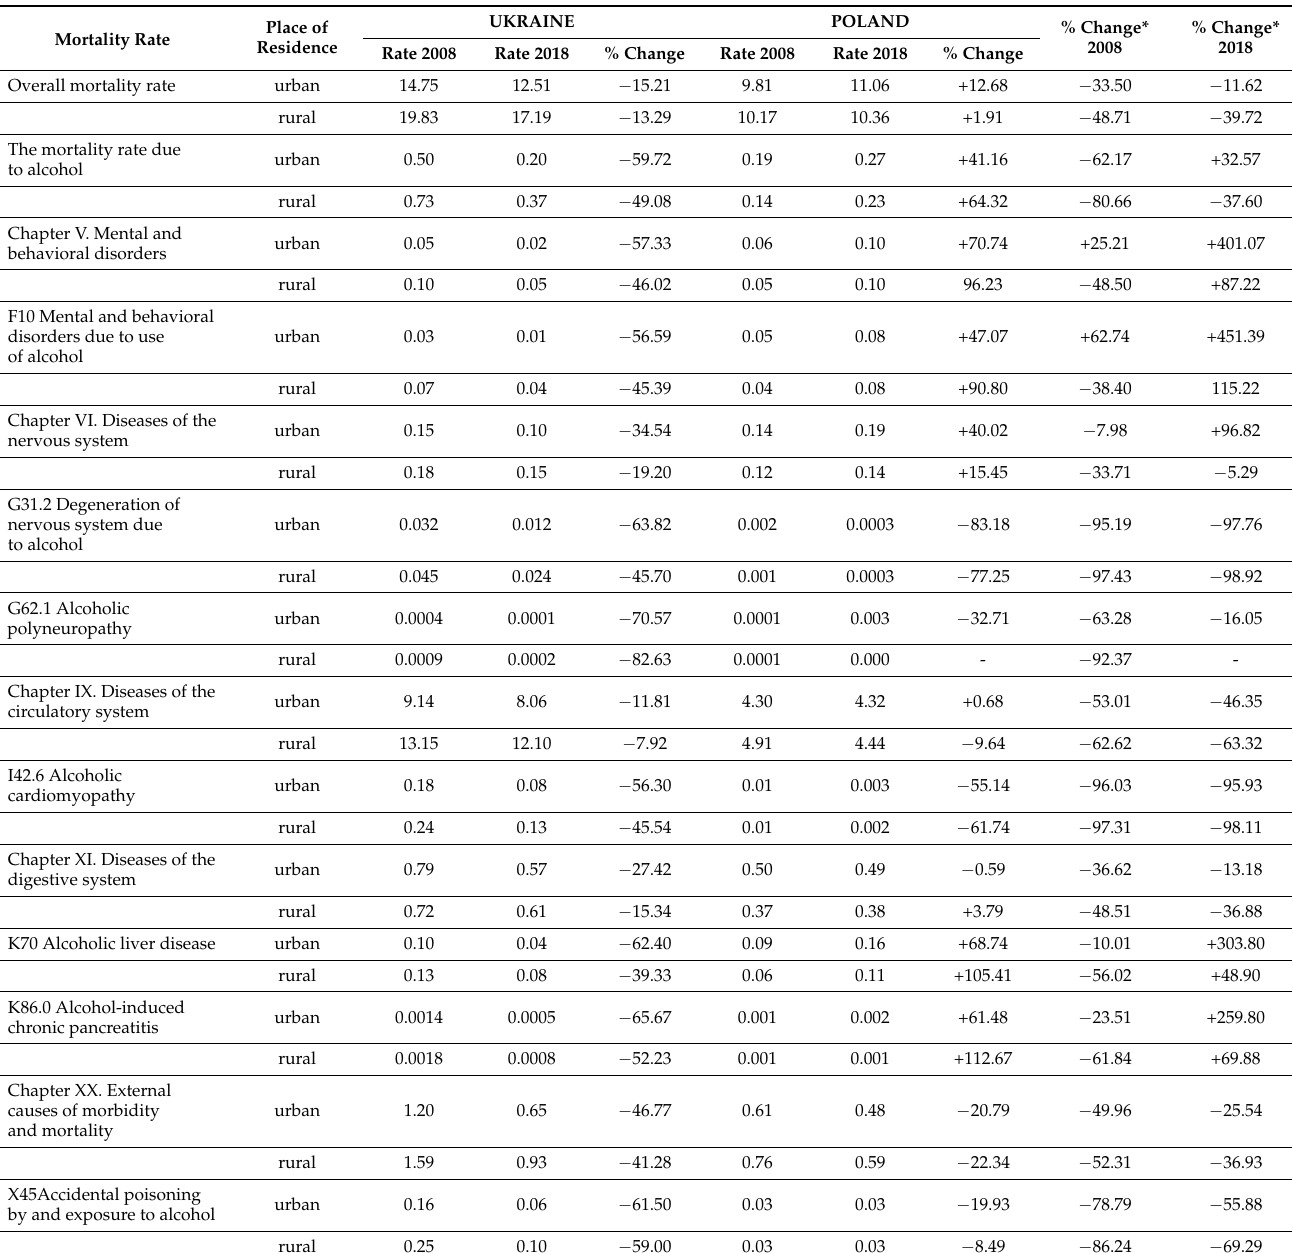
Table 3. Mortality caused by alcohol consumption by certain classes of causes of death depending on the place of residence. Mortality Rate